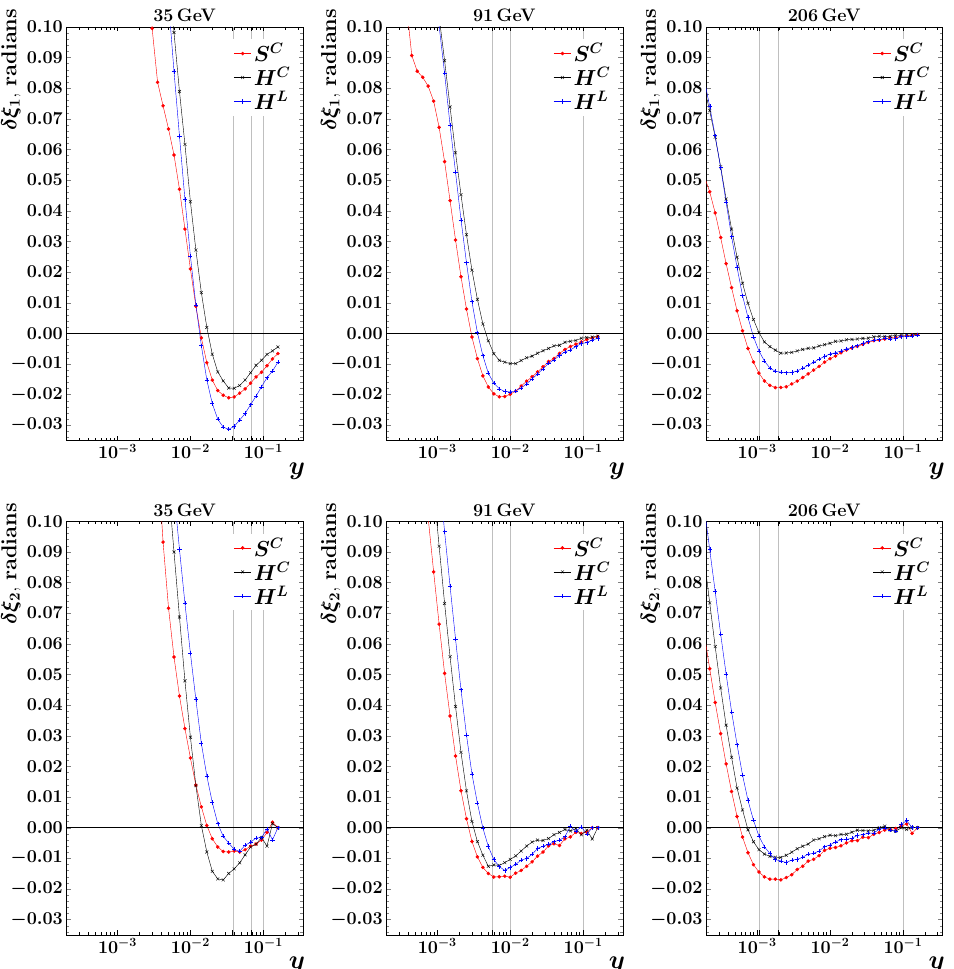
Figure 12 . Hadronization corrections obtained with S C , H C and H L hadronization models.